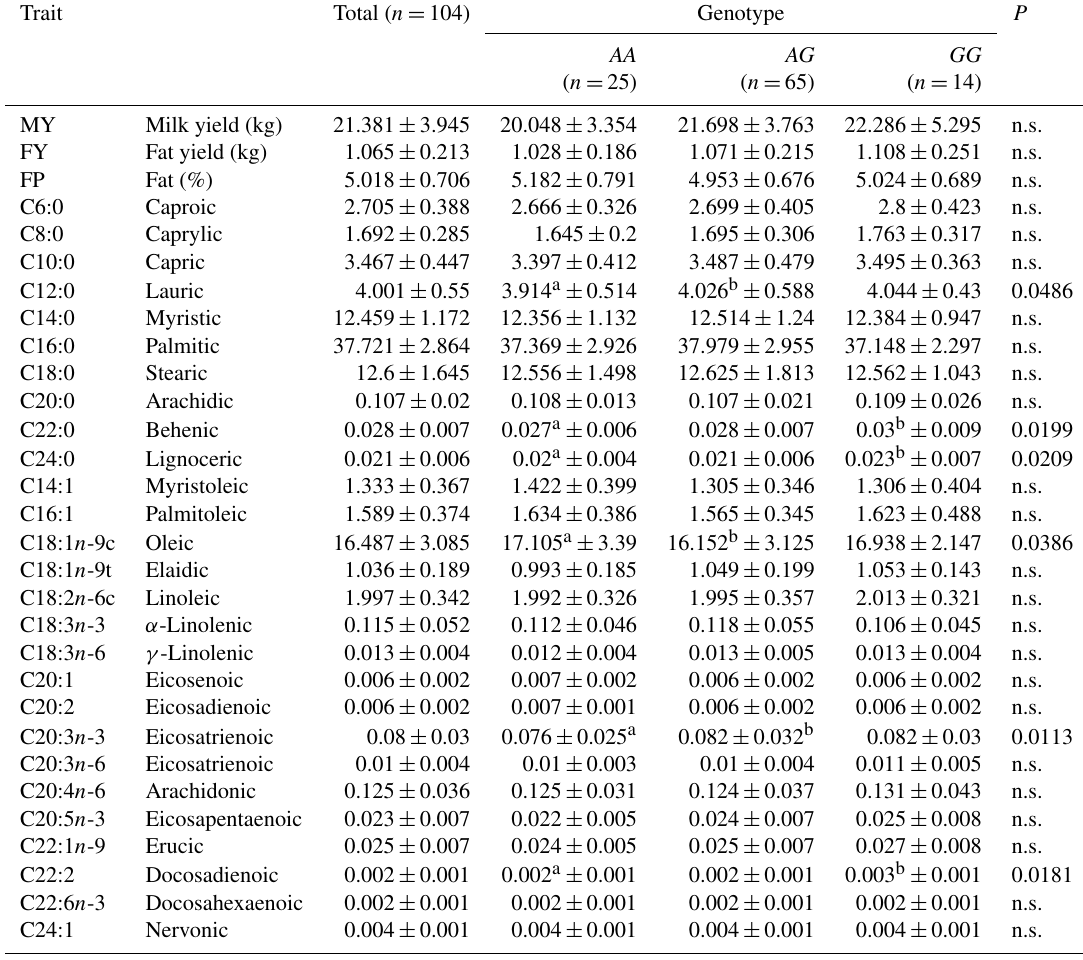
Table 3. The association of FADS2 polymorphism with the fatty acid composition (%) in the milk of Jersey cows. Trait Total ( n = 104) Genotype